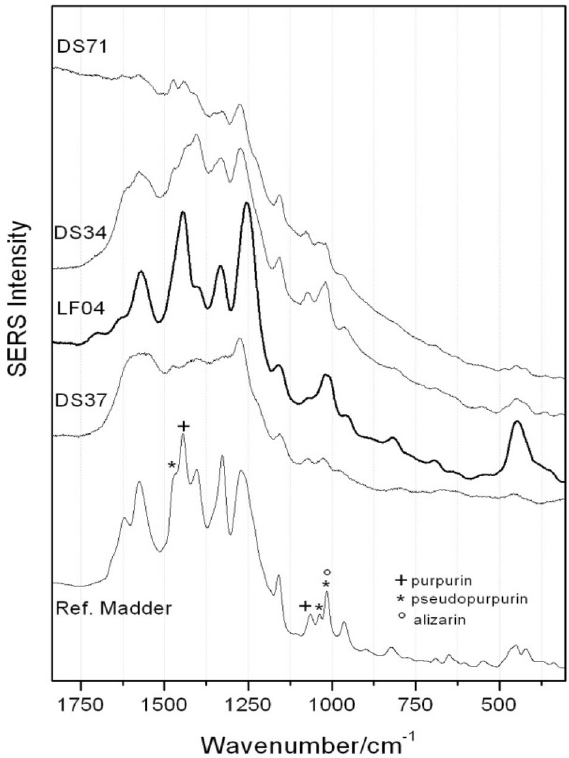
Figure 3. SERS spectra of pastels DS71, DS34, LF04, DS37 together with reference Madder lake highlighting marker bands of main madder constituents: alizarin (°), purpurin ( +) and pseudopurpurin